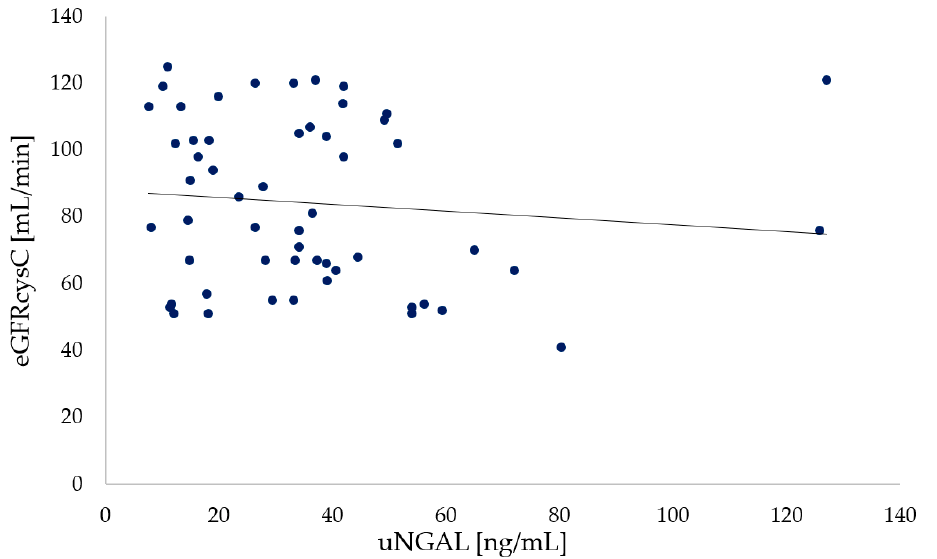
Figure 4. Relationship between urine NGAL and eGFRCKD-EPI Cystatin C in participants with CF ( p = 0.272).